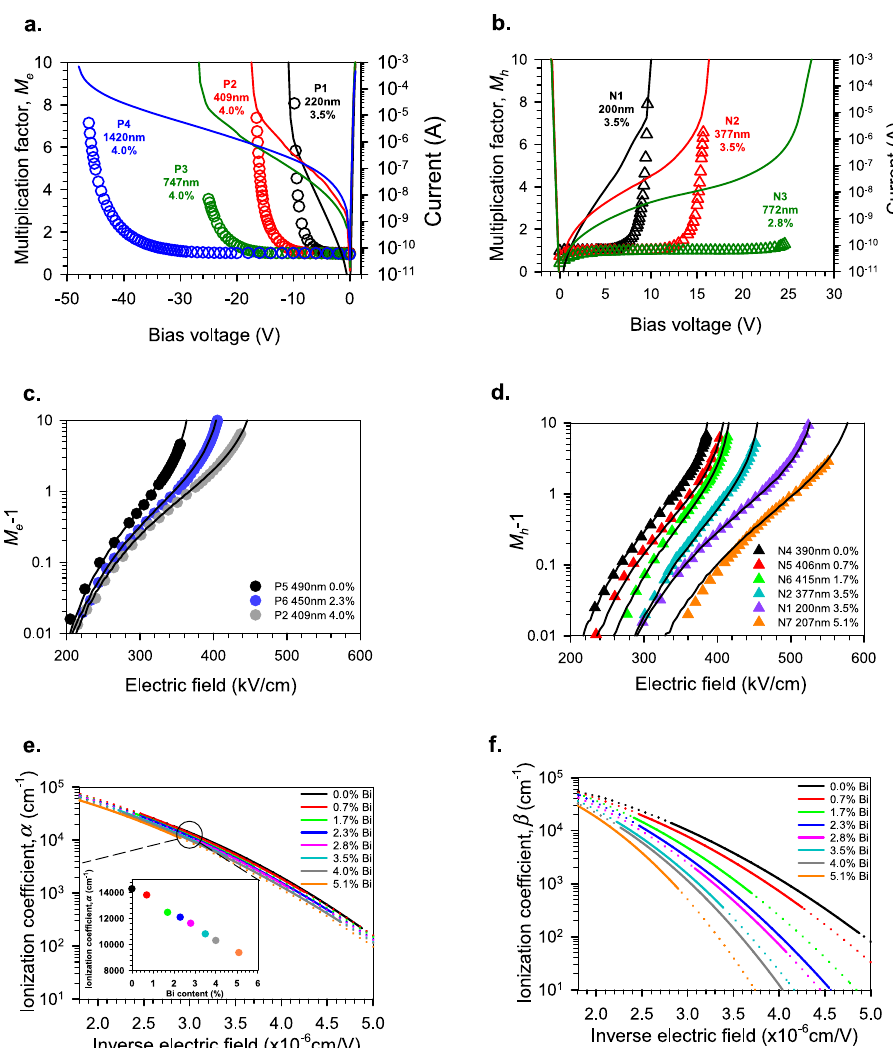
Fig. 2 Photomultiplication characteristics and ionization coef fi cients in GaAsBi. a , b The symbols show M e ( M h ) versus applied reverse bias for p-i-n (n-i-p) structures of varying i-region thickness while the solid lines show the dark currents for 50 − 100 µ m diameter devices. c , d M e − 1 ( M h − 1) vs electric fi eld for the 400nm thick p-i-n (n-i-p) diodes of different Bi contents. The solid lines show the simulated results. e α vs inverse electric fi eld at a range of Bi contents; inset shows α versus Bi content at an inverse electric fi eld of 3×10 − 6 cm/V. f β of GaAsBi vs inverse electric fi eld for a range of Bi contents. In ( e , f ) the dotted lines refer to the modelled α and β values for the different Bi compositions; the solid lines indicate the values used to fi t to the experimental data, as shown in ( c , d